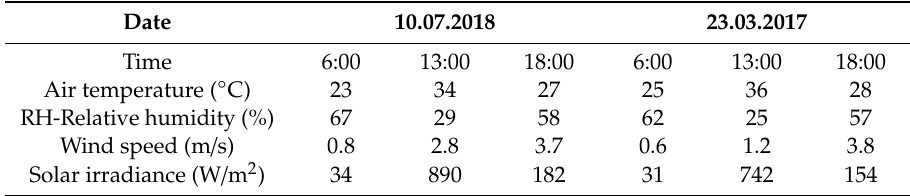
Table 3. The environmental conditions for the field thermographic